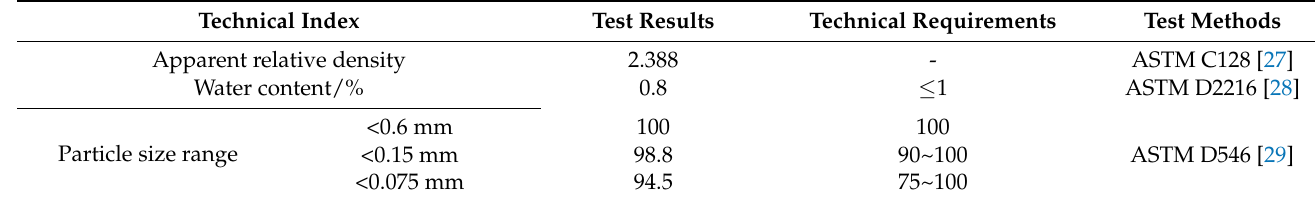
Table 2. Technical indices of the flame